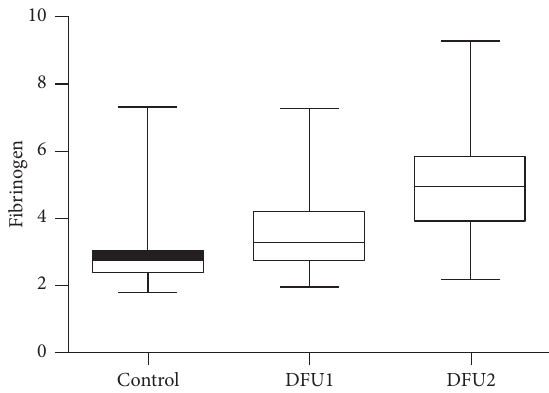
Figure 1: Box-plot representation of fibrinogen in patients with DFU grades 0-1 (DFU1) and DFU grade ≧ 2 (DFU2) and patients without DFU